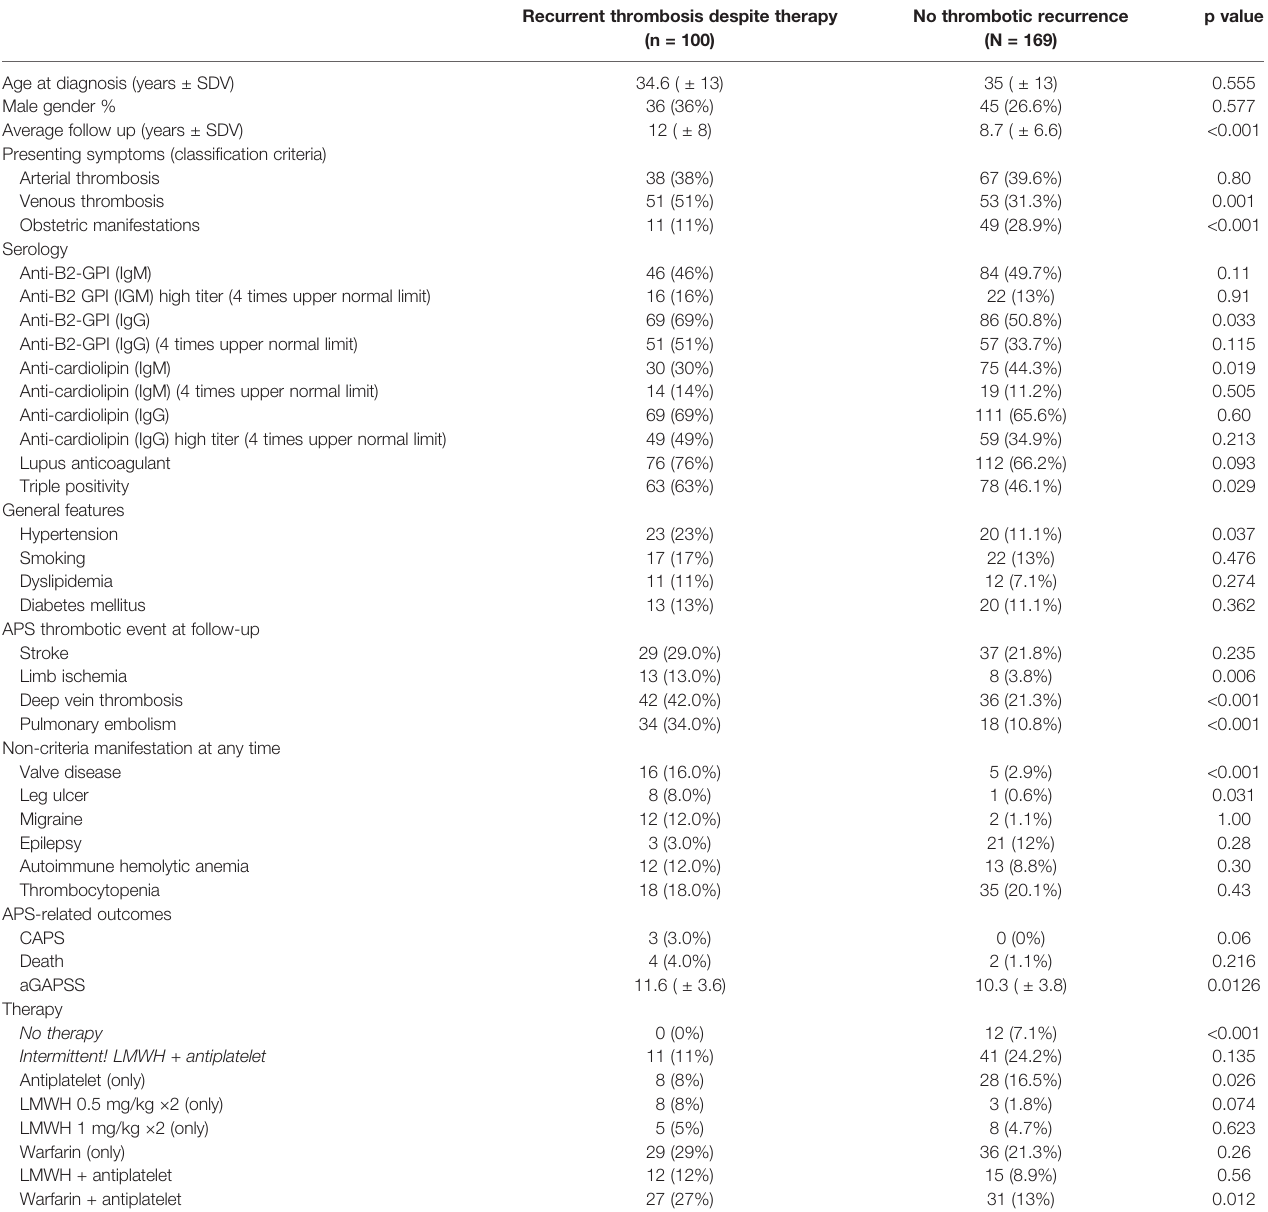
TABLE 5 | Clinical and serological parameters associated with the “ breakthrough ” pattern — e.g., APS-related event despite preventive therapy (anti-aggregation or anticoagulation).